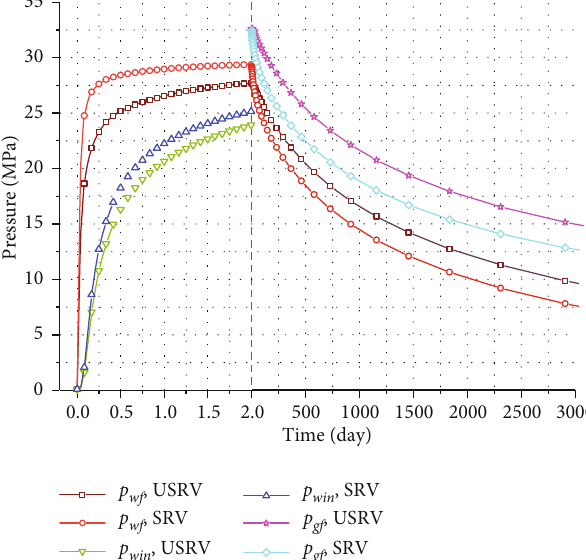
8: Evolution of average water pressure in the SRV and USRV regions during water injection.